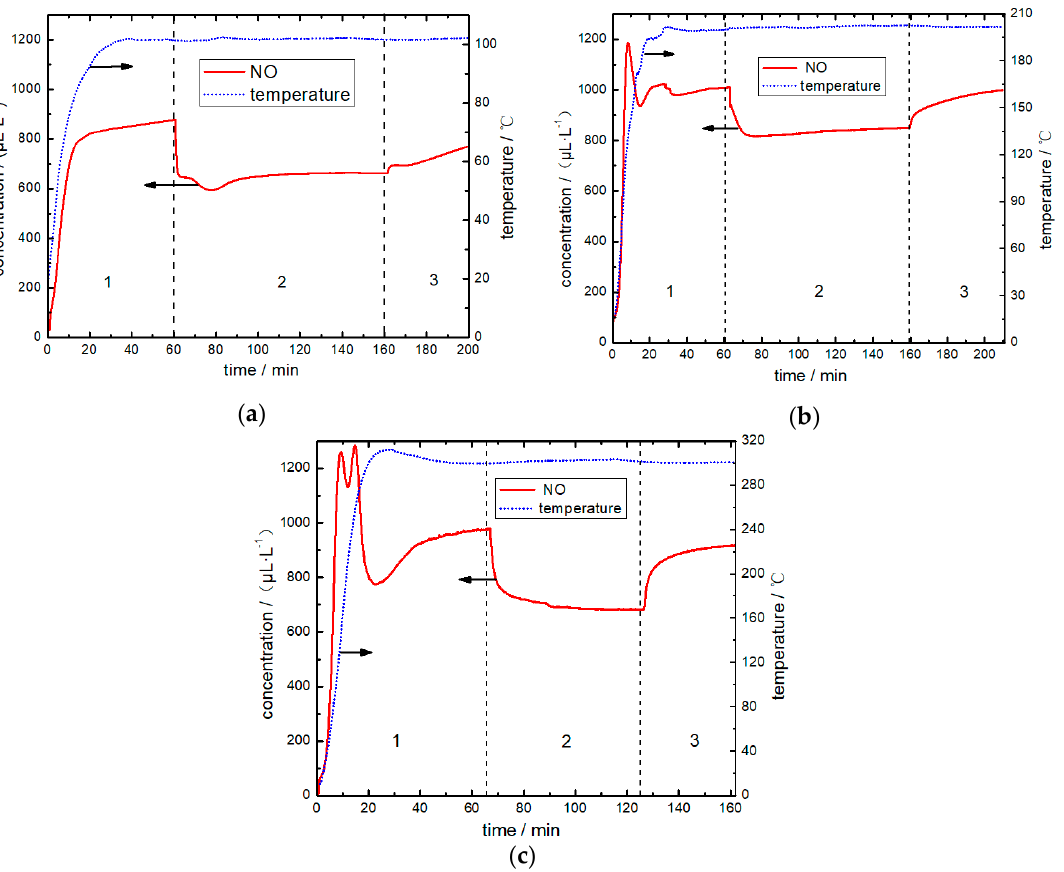
Figure 9. Effect of AC on NO + O 2 + NH 3 at high temperature. ( a ) 100 °C; ( b ) 200 °C; ( c ) 300